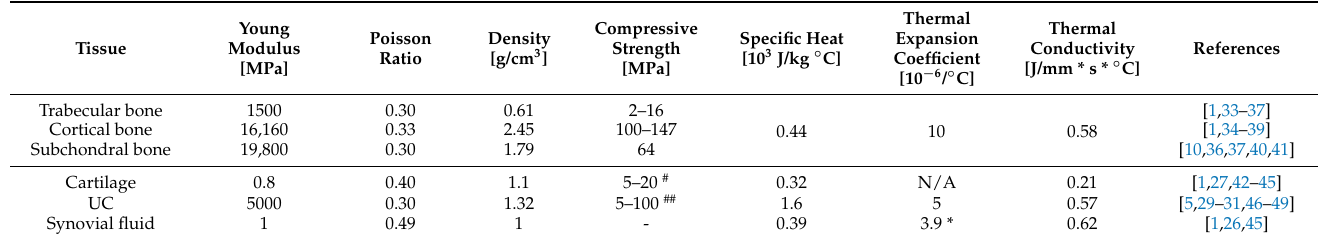
Table 1. Physical-mechanical and thermal characteristics of knee tissues used in FEA study (mean values).